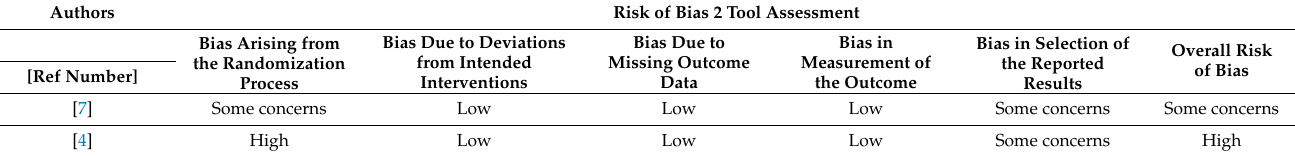
Table A3. Quality scores for the eligibility studies for all adverse